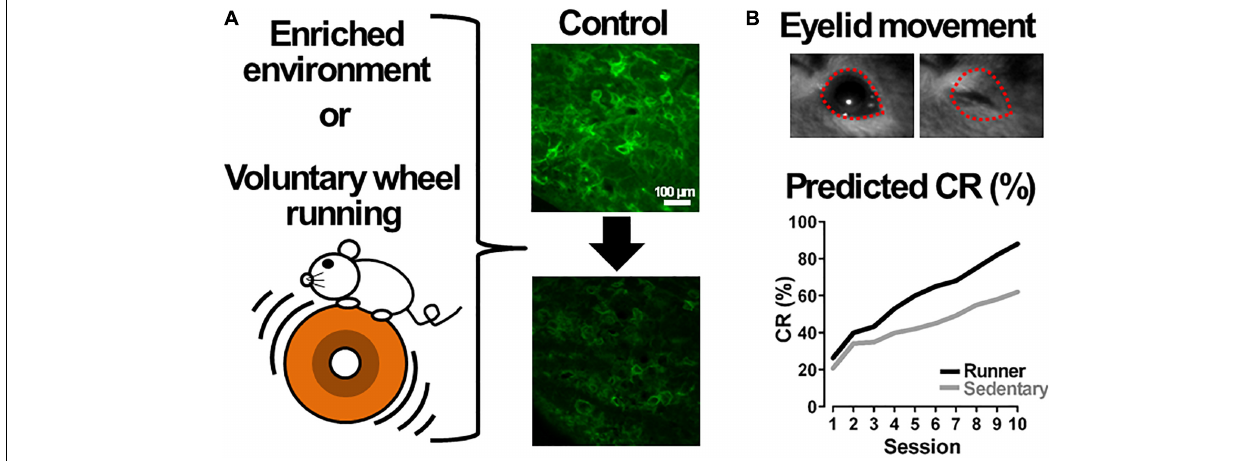
FIGURE 4 | Voluntary exercise in an enriched environment or on a running wheel could facilitate cerebellar motor learning. (A) A mouse exercises in an enriched environment (EE) or on a running wheel. EE or voluntary wheel running likely reduces the density of perineuronal nets (right panels): the upper image shows large neurons surrounded by perineuronal nets labeled by Wisteria floribunda agglutinin (green) in the mouse deep cerebellar nucleus, and the lower shows a predicted image from a mouse kept in an EE or on a running wheel. The upper image is our unpublished data. (B) Voluntary exercise could improve conditioned responses (CRs) of cerebellar motor learning in delay eyeblink conditioning. The upper image is an example of eyelid movement during mouse delay eyeblink conditioning (Hirono et al., 2018). The lower graph shows predicted learning curves obtained from a mouse kept with (Runner) or without (Sedentary) a running wheel,